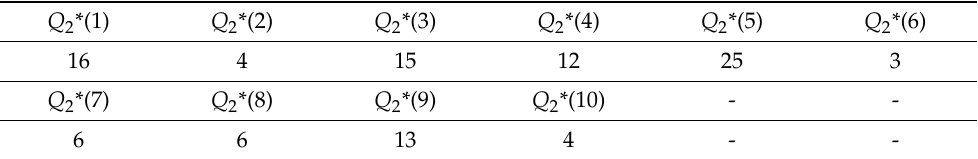
Table 5. Optimal delivery plan for warehouse 2 ( τ * = 2).